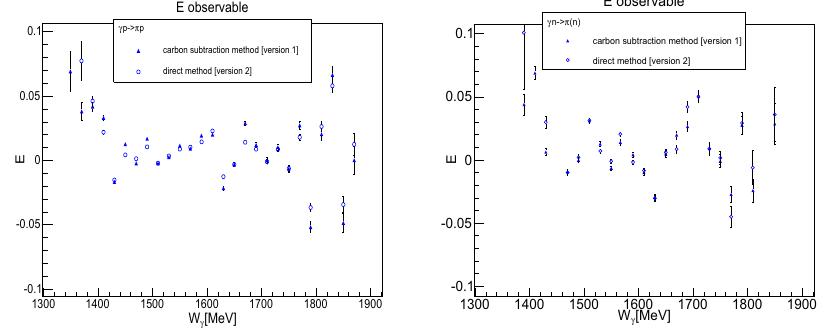
Figure 3. E -observable plot in terms of W (center of mass energy) for γ p → π 0 π + n (Left plot) and for γ n → π 0 π − p (right plot); Blue triangles are for the method with carbon subtraction and the open circles correspond to the direct